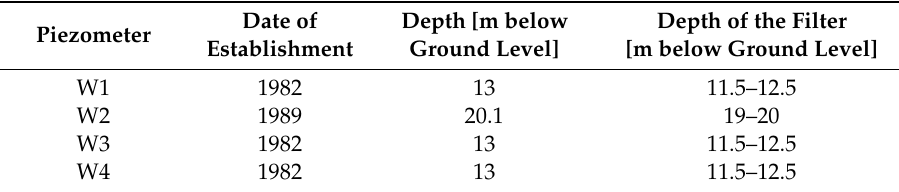
Table 1. Specification of piezometers W1–W4. Source: own study based on internal, not published, plant’s